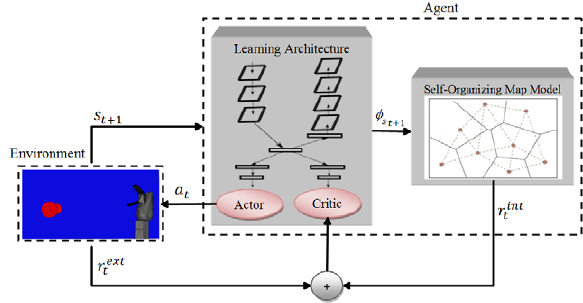
Figure 3: Deep ICAC learning system: The agent takes an action a t chosen by the actor in state s t and the environment returns a new state s t +1 and reward r ext . The convolutional encoder of the agent’s t learning architecture then computes a feature representation ϕ s